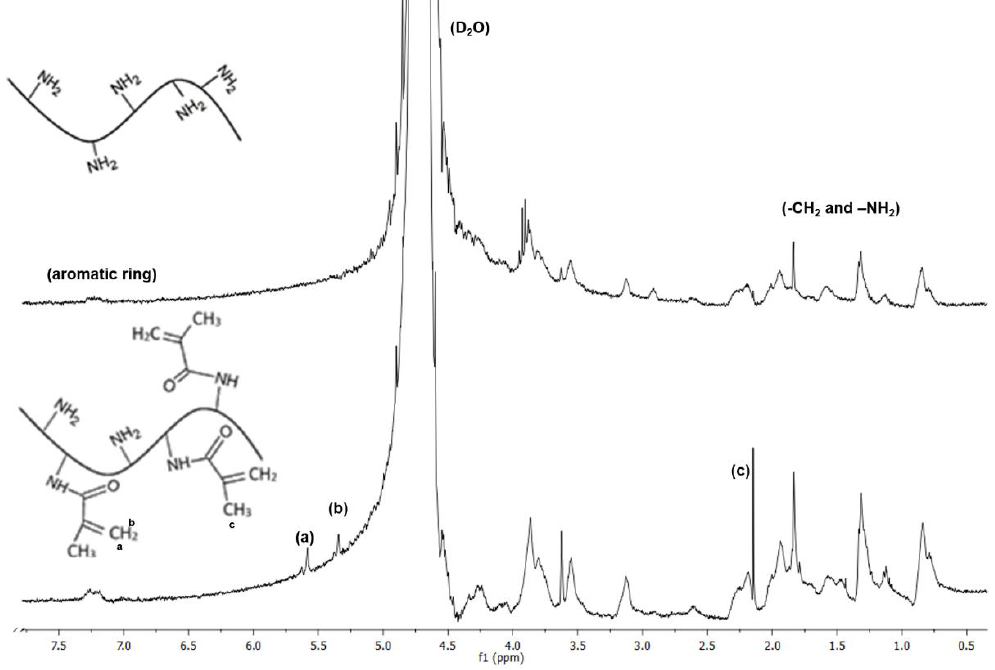
Figure 2. NMR spectra of the original and functionalized chitosan (ChMA). 228